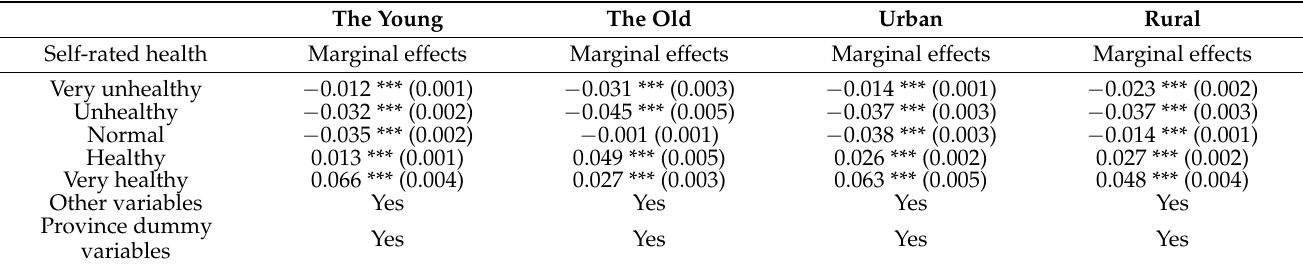
Table 6. Marginal effects of happiness on self-rated health.